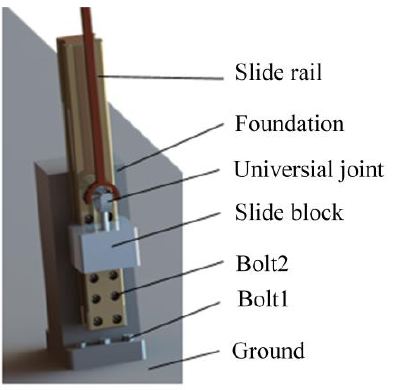
Figure 19. Bottom structure.